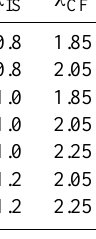
Table 4. The performance of the various configurations